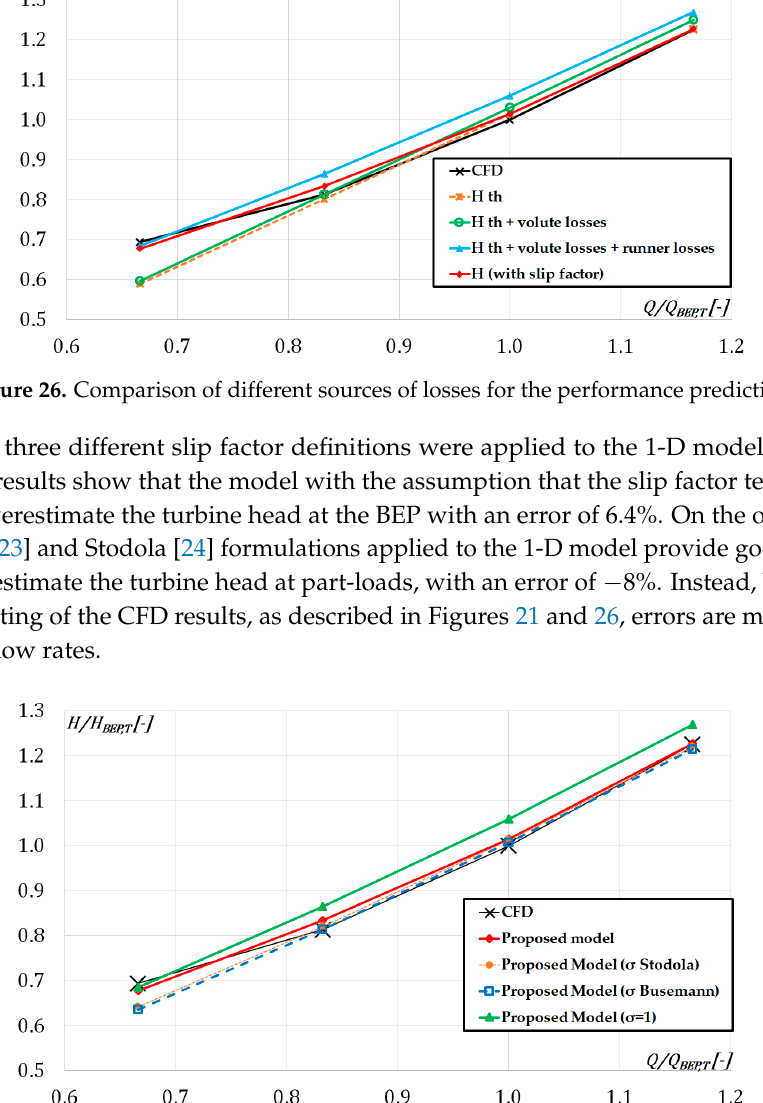
Figure 27. Comparison of different slip factor definitions (i.e., σ turbine , σ proposed by Busemann [23], σ proposed by Stodola [24] and σ = 1) with the CFD